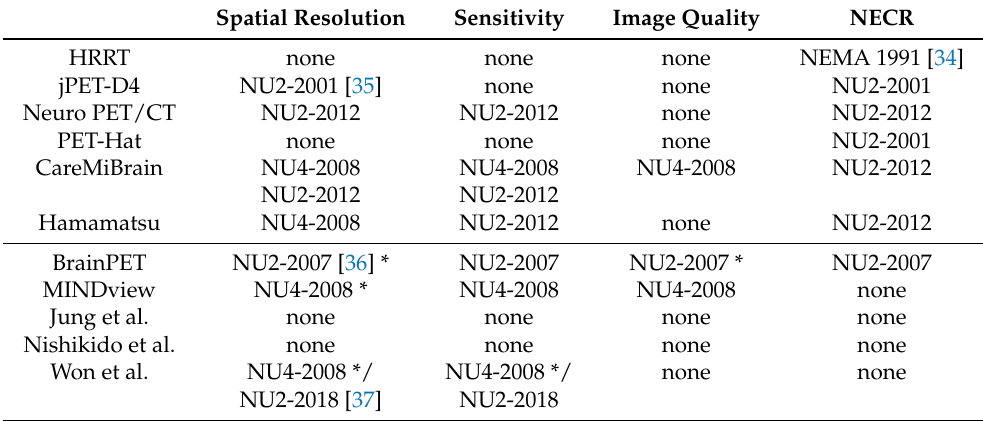
Table 3. NEMA standards (spatial resolution, sensitivity, image quality and noise equivalent count rate (NECR) ) used for evaluating system performance. The asterisk means that modifications have been done to the original